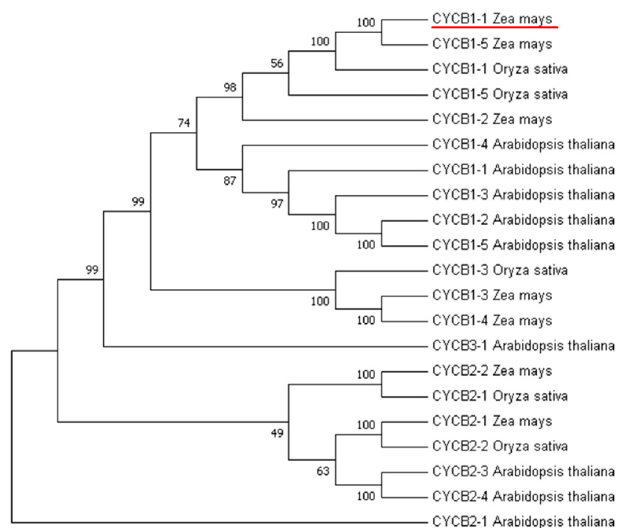
Figure 1. Phylogenetic analysis of CYCB gene families in maize, rice, and Arabidopsis. Table 1. Basic characteristics of CYCB family genes in Arabidopsis, rice, and maize.